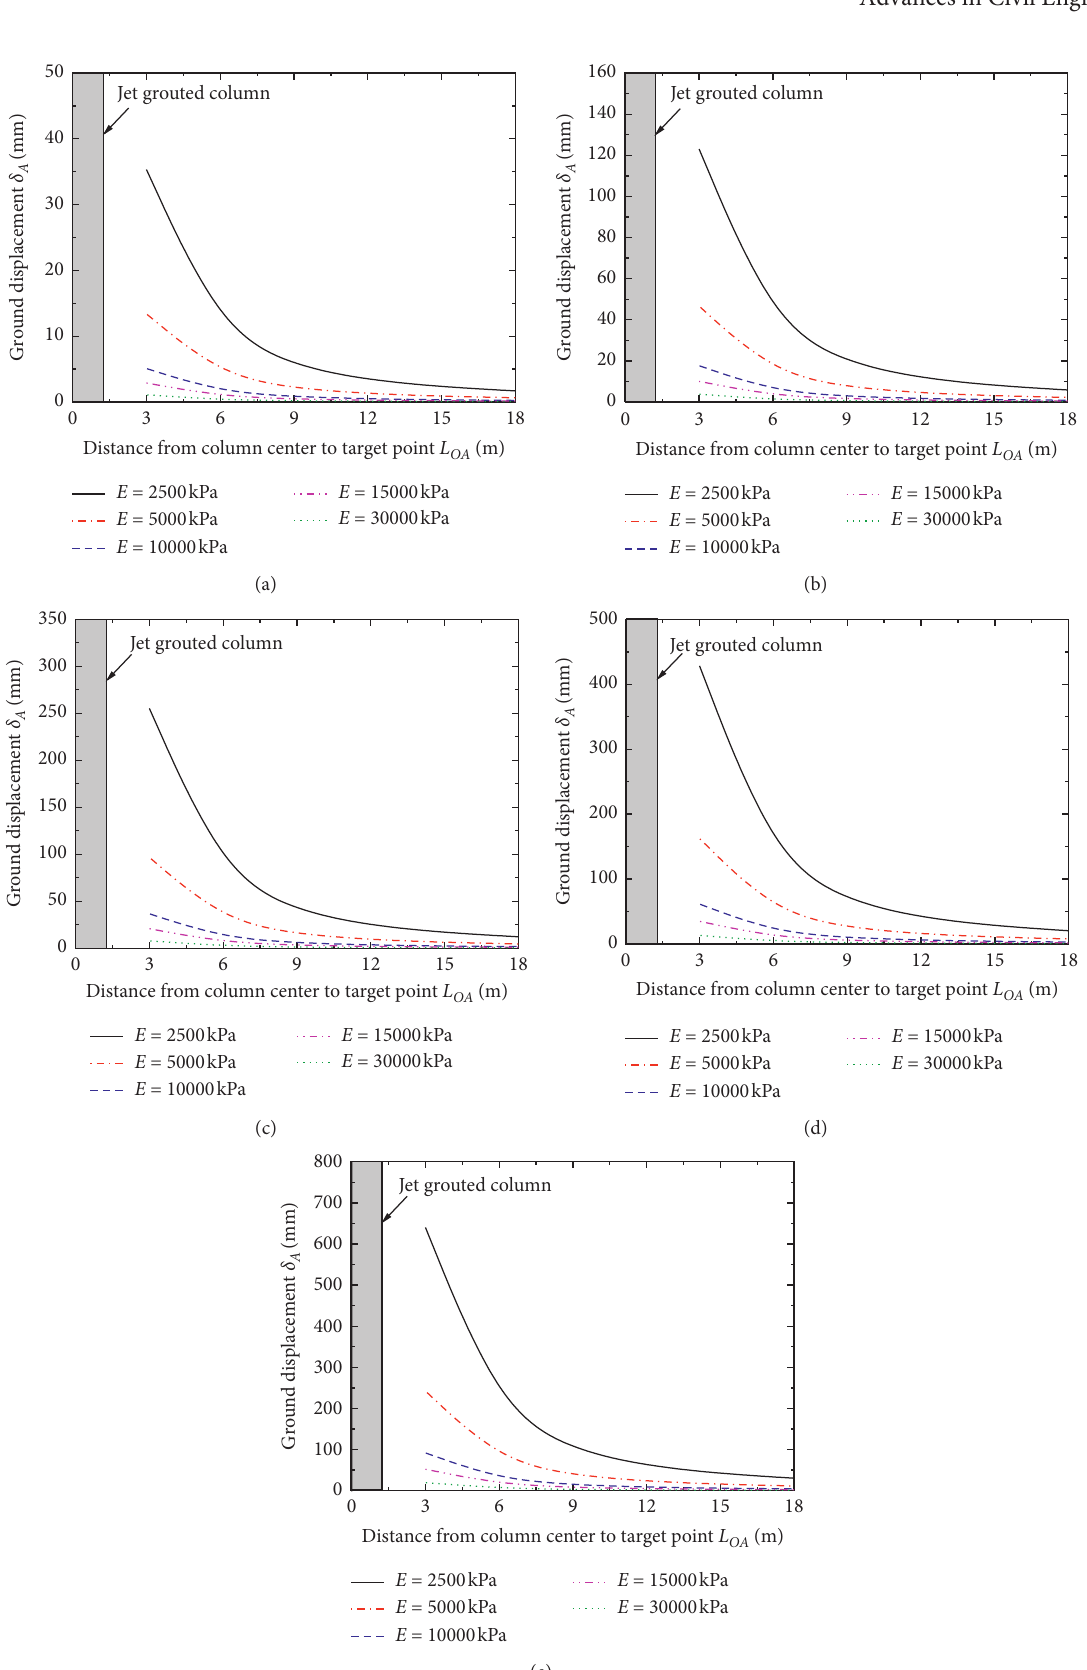
� 0.25m; (b) R � 0.50m; (c) c c